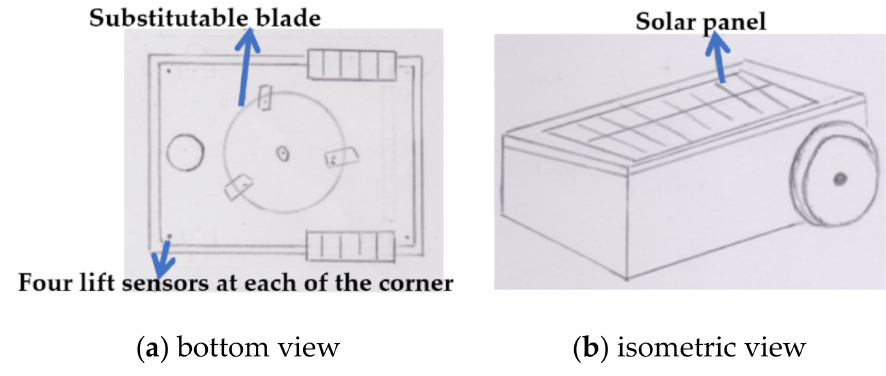
Figure 2. Hand-sketched drawing of final concept.